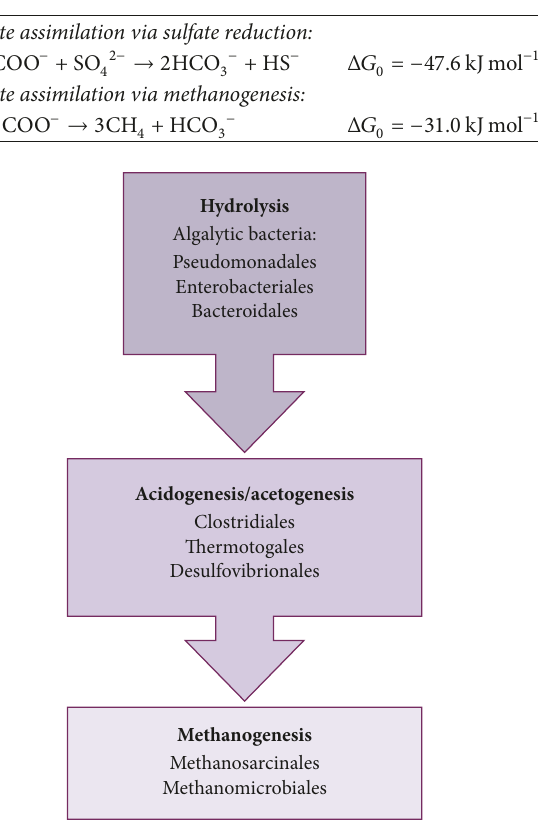
Figure8:Proposedsetofkeymicroorganismsinvolvedinanaerobic digestion of microalgal biomass and sodium